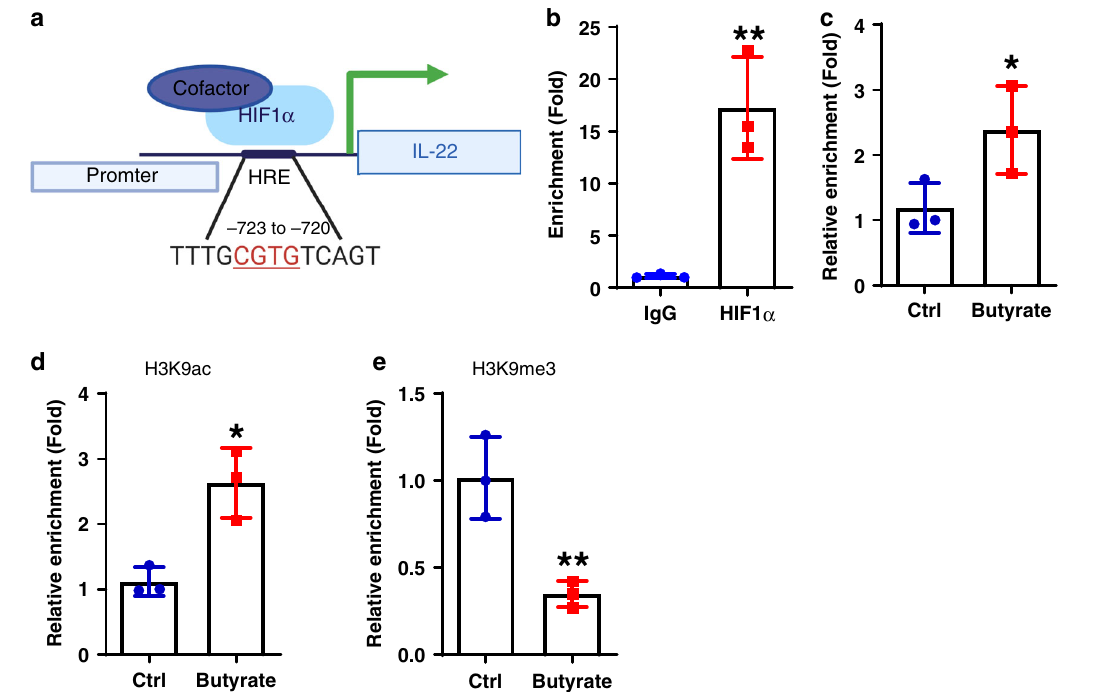
Fig. 6 Butyrate promotes HIF1 α binding to Il22 promoter in CD4 + T cells. a Schematic diagram of HIF1 α binding to Il22 promoter. b WT CD4 + T cells were activated with anti-CD3/CD28 mAbs under Th1 conditions for 2 days ( n = 3/group). HIF1 α binding to Il22 promoter was analyzed by CHIP assay. c – e WT CD4 + T cells were cultured under Th1 conditions with or without butyrate (0.5 mM) for 2 days ( n = 3/group). HIF1 α binding to Il22 promoter was analyzed by CHIP assay ( c ). The H3K9 acetylation ( d ) and trimethylation ( e ) levels in HIF1 α -binding site on Il22 promoter were assessed by CHIP assay. One representative of three independent experiments ( b , c ), or two independent experiments ( d , e ) was shown. Data were expressed as mean ± SD. Statistical signi fi cance was tested by two-tailed unpaired Student t -test. b ** p = 0.0047; c * p = 0.0278; d * p = 0.0105; e ** p =